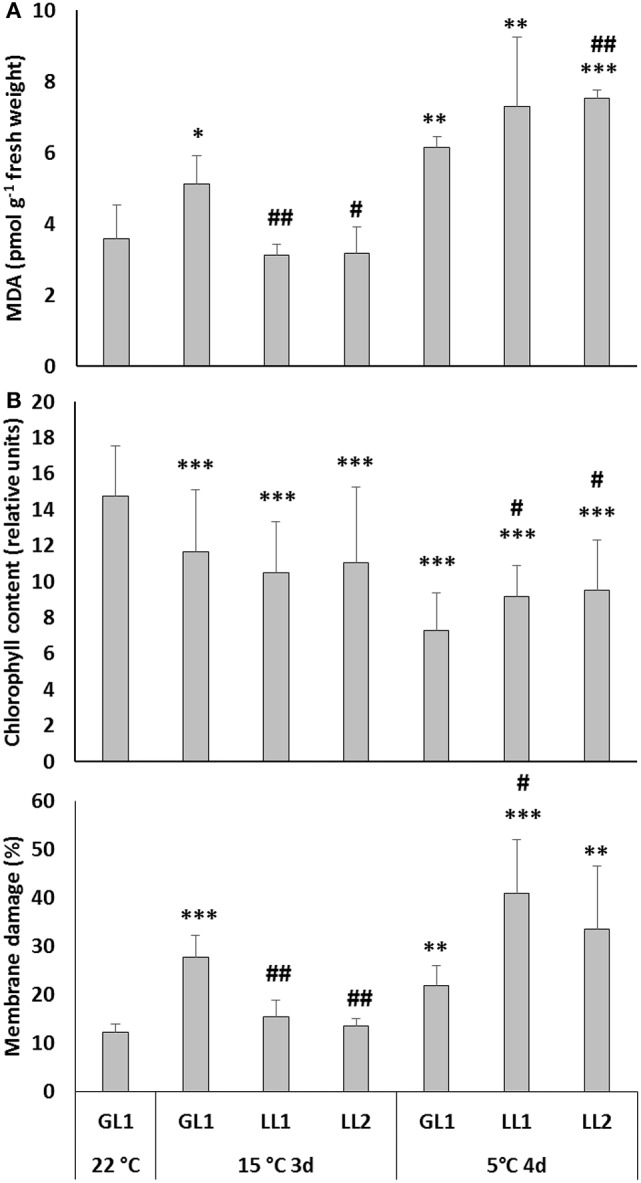
MDA levels (A) chlorophyll content represented with SPAD-values (B) and membrane damage measured as electrolyte leakage (C) in the leaves of plants grown at GL1 before and after cold hardening at 15°C at GL1, LL1, or LL2, and after chilling stress at 5°C at GL1. *, **, ***Significant differences compared to the GL1 22°C plants at the p < 0.05, 0.01, and 0.001 levels, respectively. #, ##, Significant differences compared to the GL1 plants on the same day at the p < 0.05 and 0.01 levels (mean ± SD, n = 5 for MDA, and n = 10 for SAPD and electrolyte leakage values).